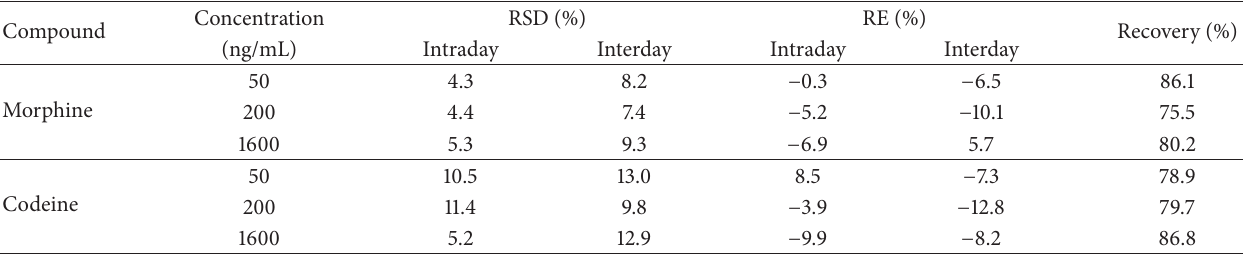
Table 1: The results of precision, accuracy, and recovery studies for morphine and codeine in human urine (𝑛 = 6) . Compound